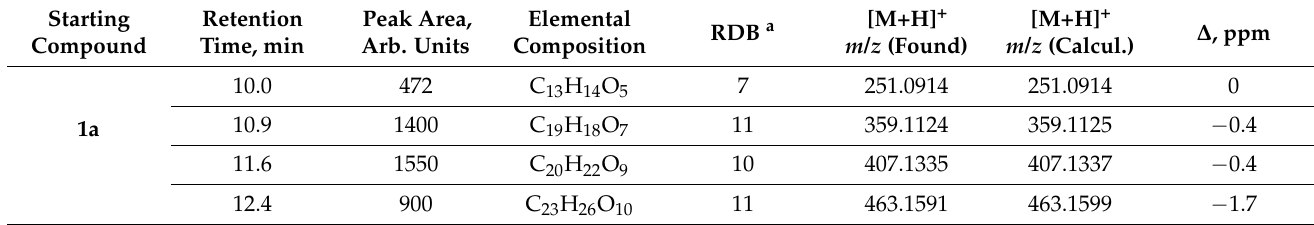
Table 3. The main products detected in reaction mixtures of 1a and 1b with benzene in H 2 SO 4 by